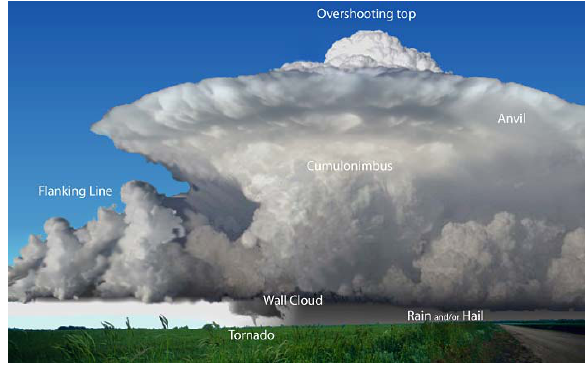
Fig. 4. Image (visible band, Meteosat 9 HRV 0.7 micron) of the situation in Fig. 1c, focused on the most northerly part of the Adri- atic Sea. Note the strong complex overshooting and the surrounding gravity waves approaching the coast from